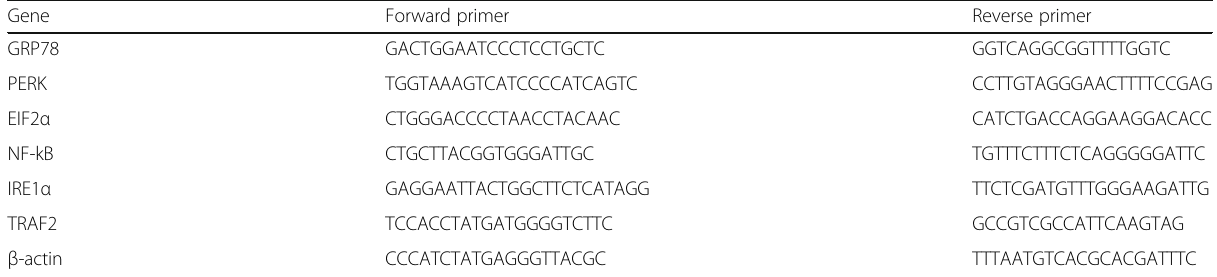
Table 1 List of primers